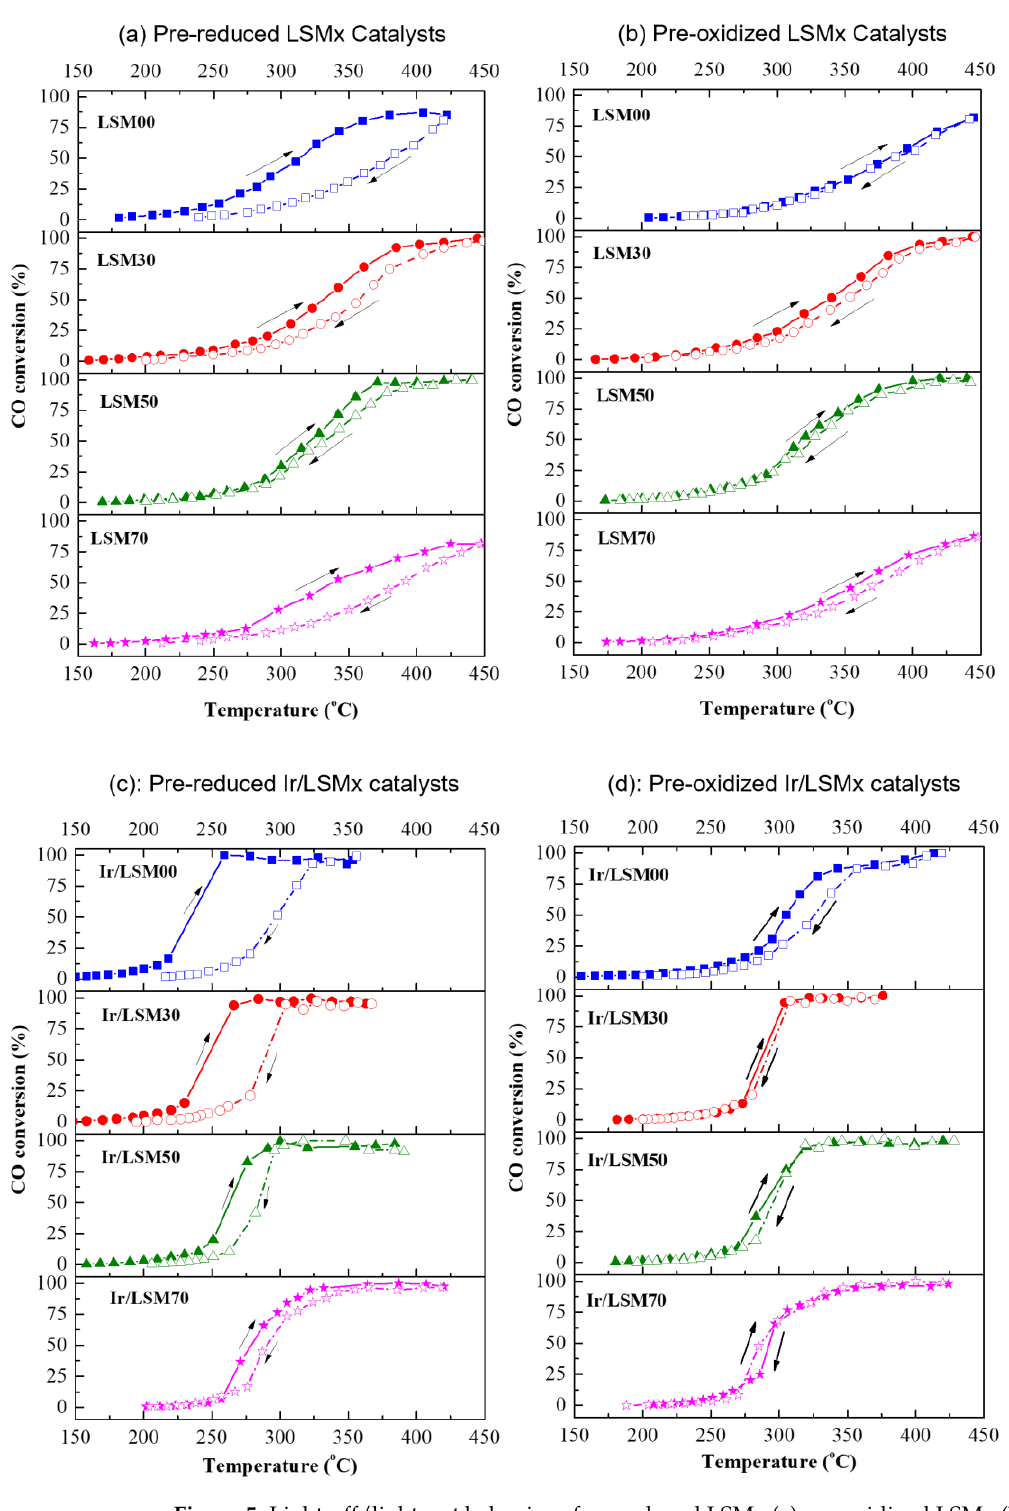
Figure 5. Light-off/light-out behavior of prereduced LSMx ( a ), preoxidized LSMx ( b ), prereduced Ir/LSMx ( c ) and preoxidized Ir/LSMx ( d ) catalysts and prereduced ( a ) and LSMx ( b ) catalysts. Display of inverse temperature (clockwise) hysteresis phenomena; arrows show the direction of the experiment.